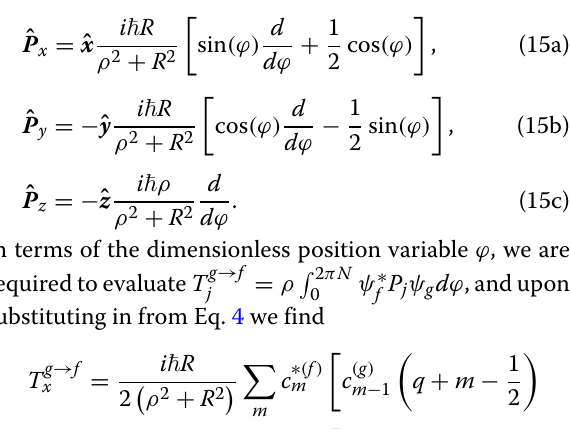
is in fact the same band). As the strength of the dou- bled period potential A g is increased with respect to B g ,